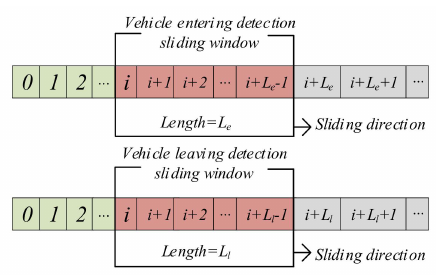
Figure 6. The implementation of sliding window algorithm for our